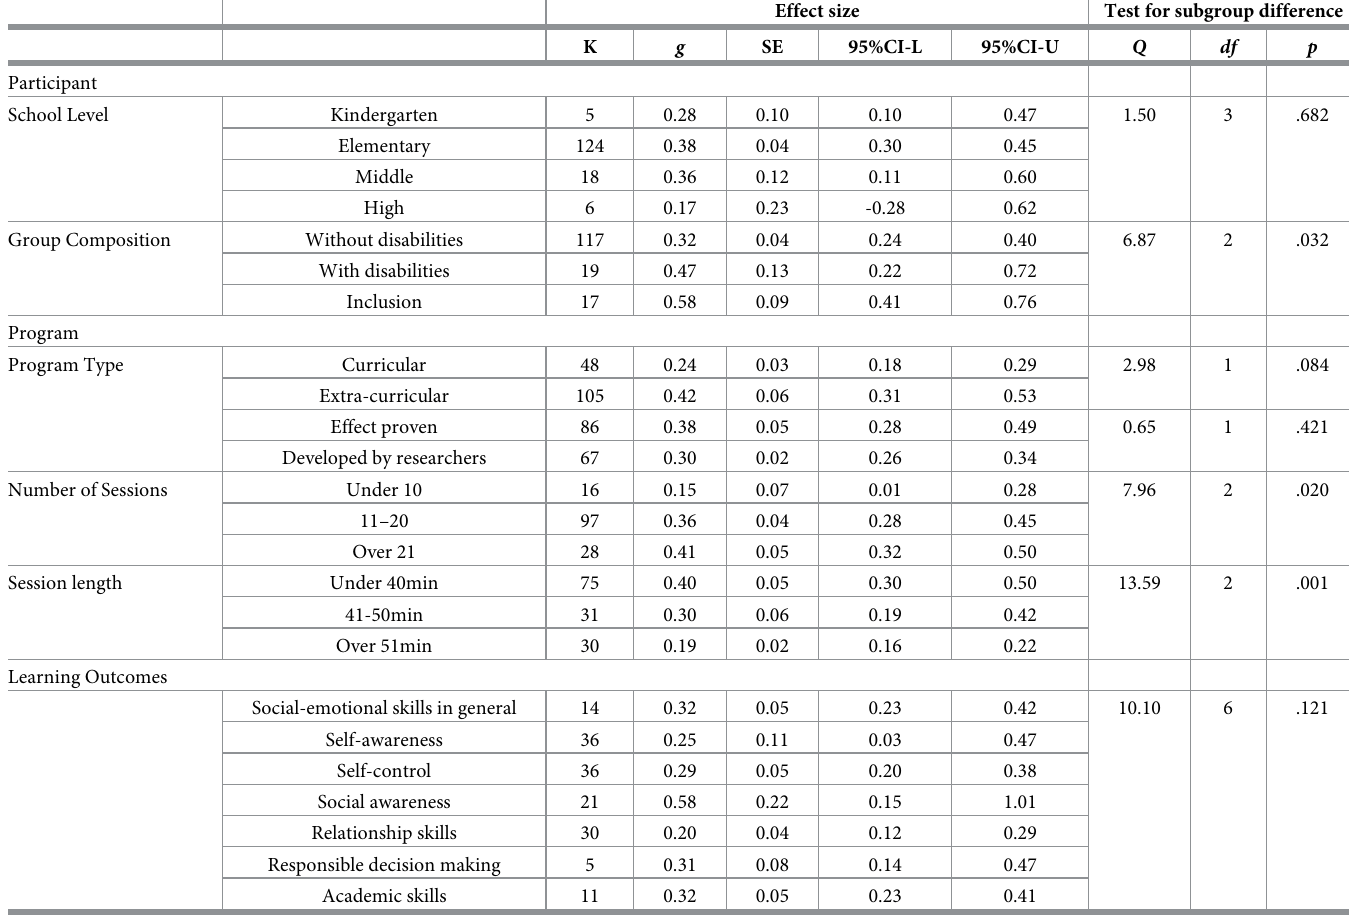
Table 4. Effect size analyses by controlling variables.